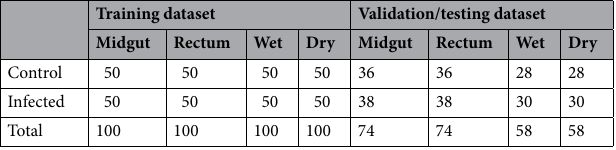
Table 2. Number of spectra used in training, validation and testing